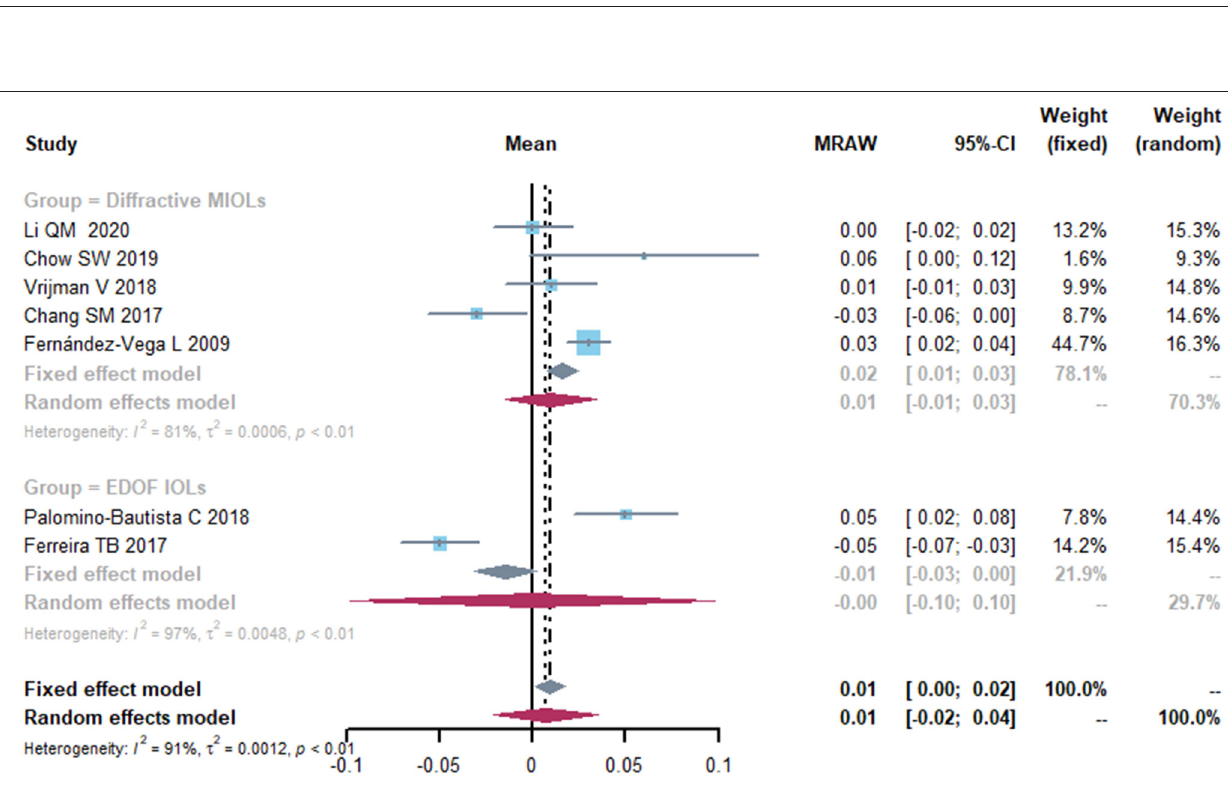
Frontiers in Medicine |